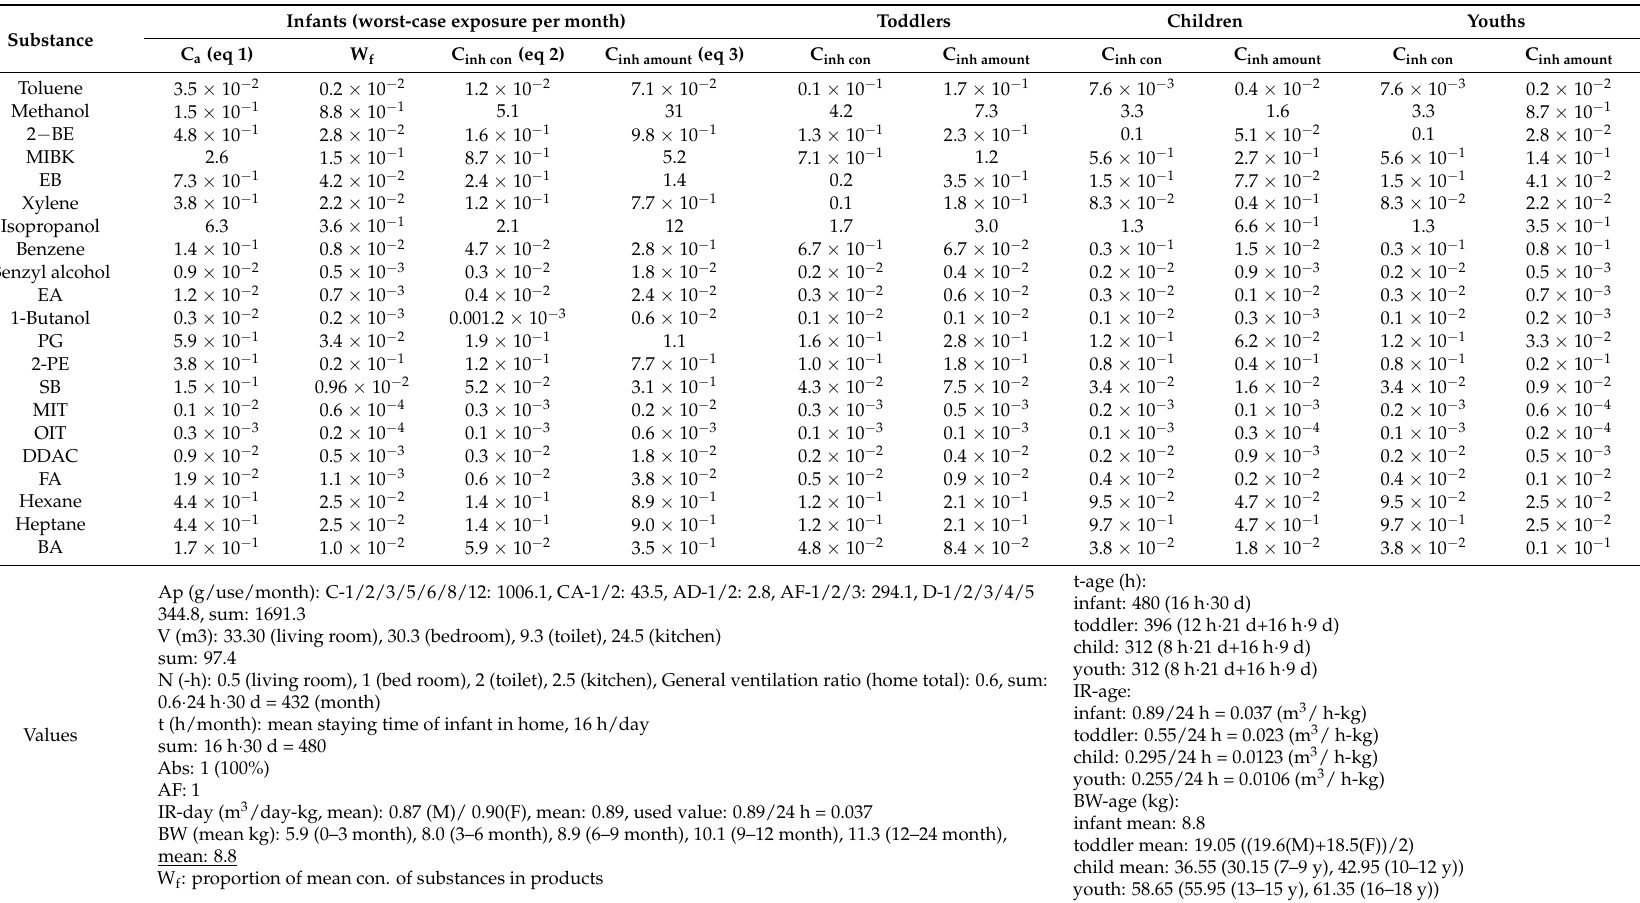
Table 6. Worst-case combined exposure concentrations via